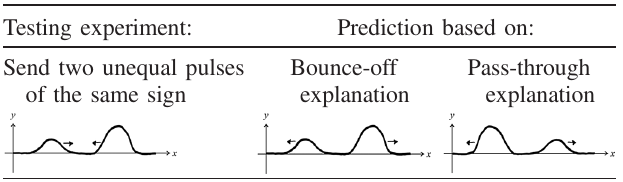
TABLE I. Making predictions based on the two explanations for how the two unequal pulses of the same sign will interact.